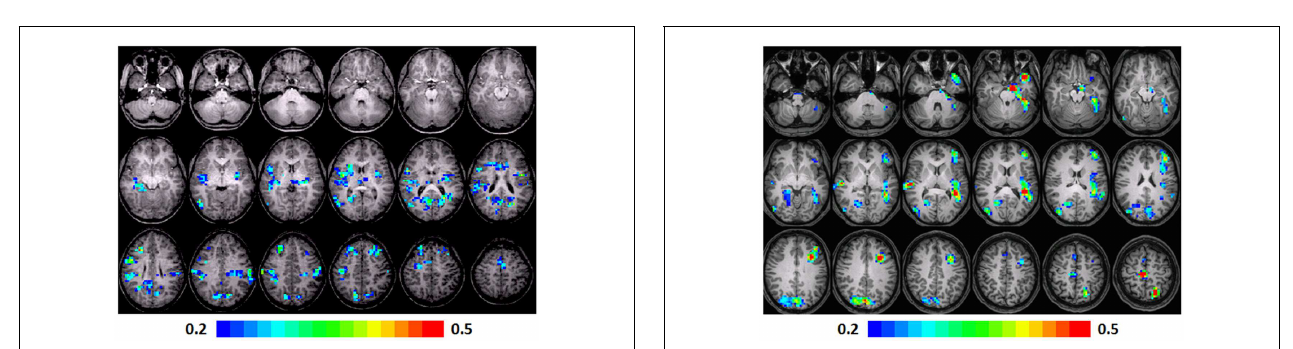
FIGURE 4 | Regression maps showing a positive correlation for activation during verb generation scans inT1 with the Letter–Word score from theWoodcock–Johnson III ( N = 16) inT3. All activated pixels meet significance threshold of p < 0.05, corrected. Slices range from z = 7 to 24 in theTalairach frame. Cluster size is 35 voxels. Higher significance is indicated in hotter color ( r value ranged from 0.2 to 0.5, see scale in the bottom of the figure). Figure is presented in a radiological orientation (L = R, R = L).